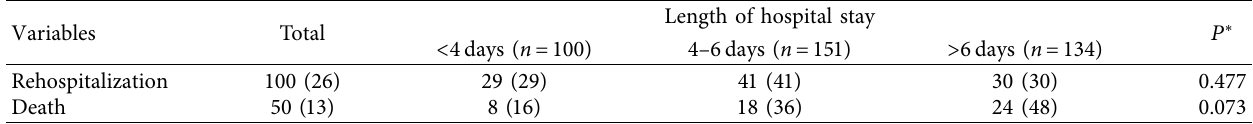
Table 2: Distribution of rehospitalization and death among the study population according to the length of hospital stay. Variables